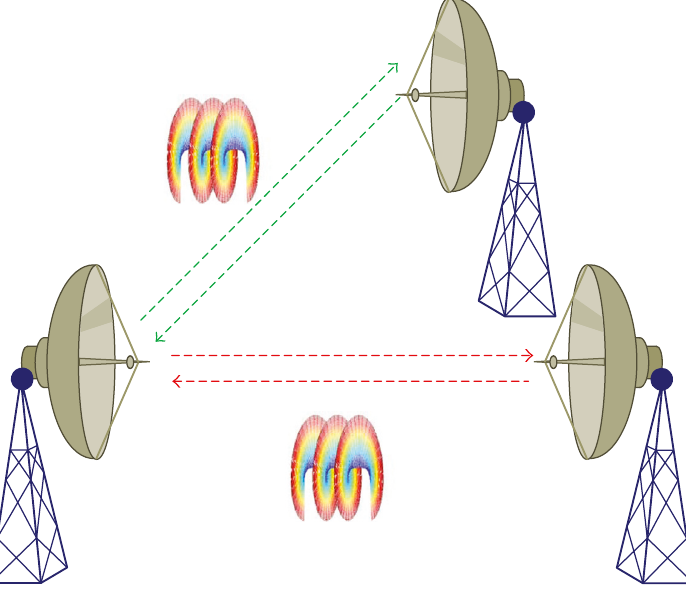
Figure 1: OAM-based communication